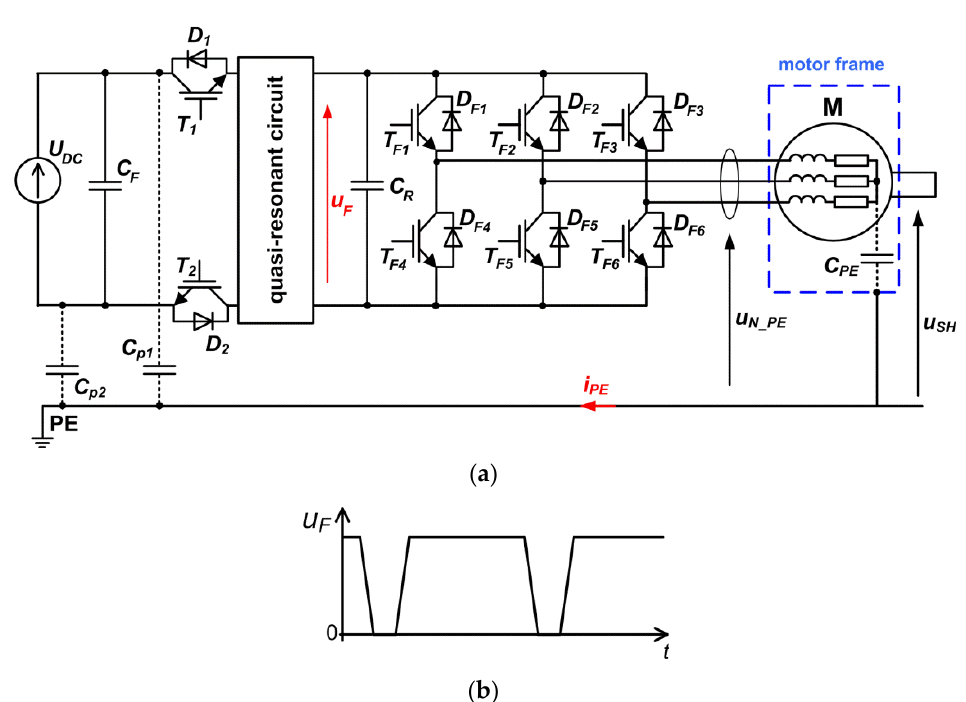
Figure 8. Concept of the parallel quasi-resonant DC link inverter (PQRDCLI) with two insulating switches T 1 , D 1 and T 2 , D 2 : ( a ) scheme; ( b ) u F zero voltage notches.